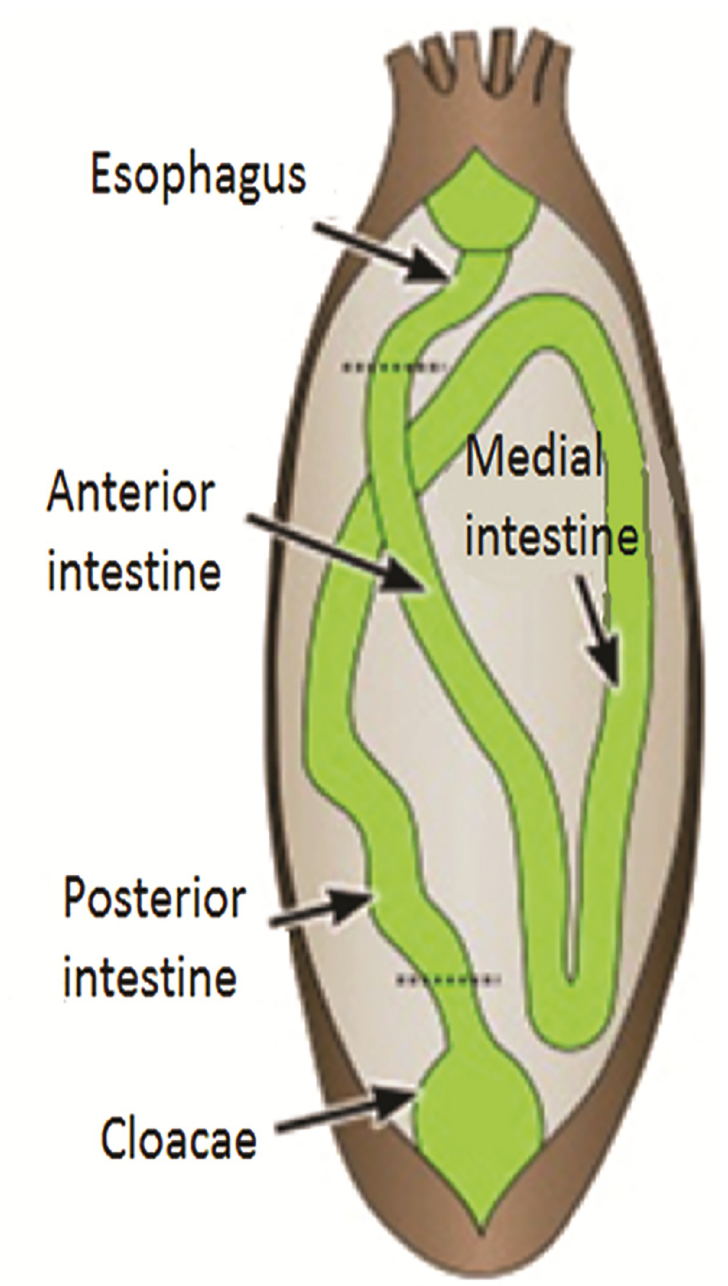
Fig 1. Anatomy of the digestive tract of the sea cucumber H . glaberrima . The digestive tract of H . glaberrima is formed by a continuous tube that begins at the mouth, forming a short esophagus which is attached to a long descending small intestine (anterior) and a long ascending small intestine (medial). The final segment of the tube is a descending large intestine (posterior) that ends in the cloacae. (Diagram obtained from Mashanov et al. 2012. Adapted by